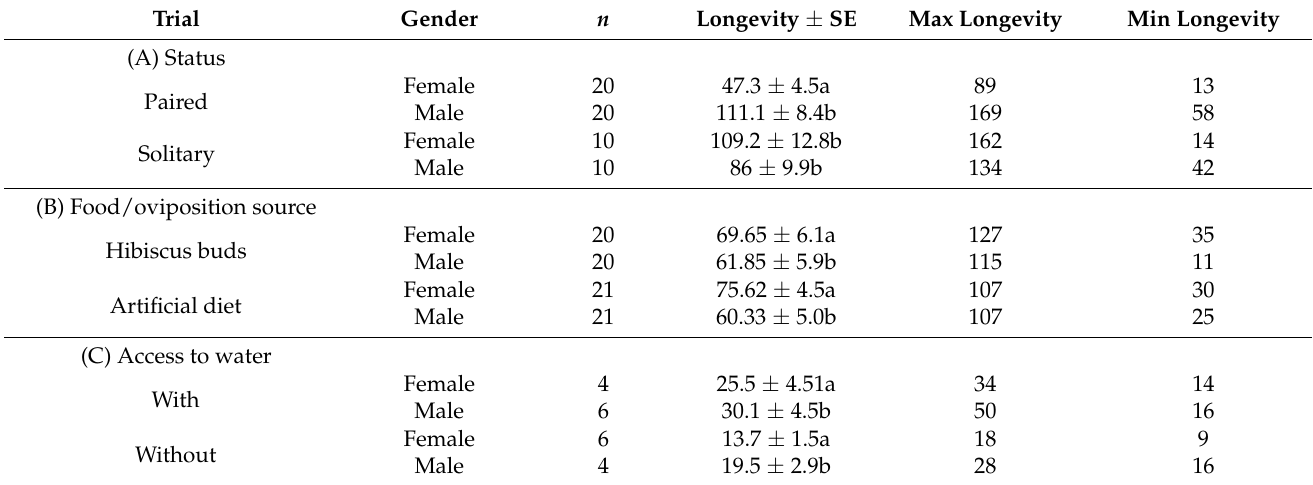
Table 5. Mean adult longevity (days) of hibiscus bud weevils ( Anthonomus testaceosquamosus ) in different trials addressing their (A) status (paired vs. solitary) when feeding on hibiscus flower buds; (B) development on artificial diet, as they were offered either hibiscus flowers buds or artificial diet as food and oviposition substrate; and (C) access to water when no other food source was offered. Within each trial, columns with different letters indicate significant differences (Tukey, p <